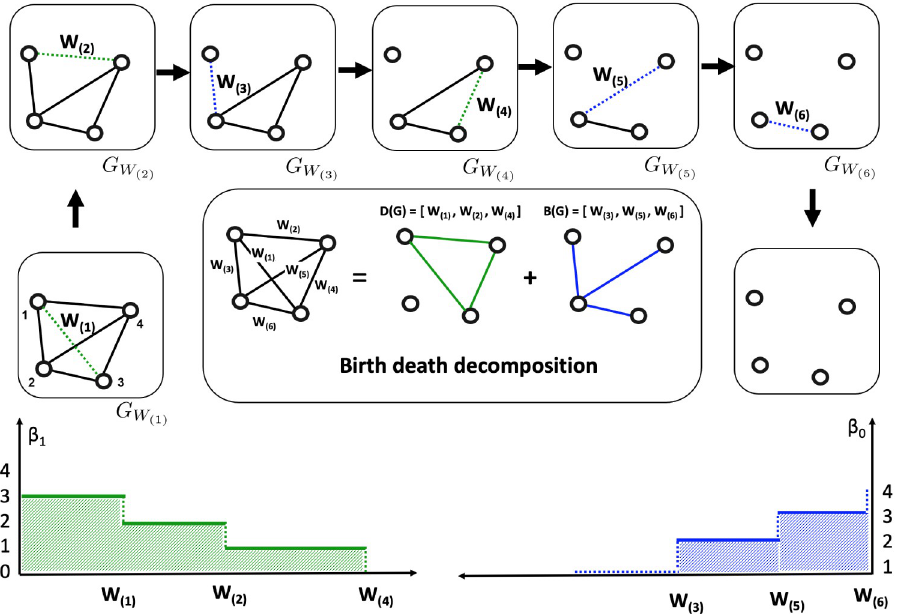
Fig 1. Schematic of graph filtration and persistent barcodes computation. We consider a random weighted graph with p = 4 nodes, where the number of edges is q = p ( p − 1)/2 = 6. The random edge weights are { W 1 , W 2 , ... , W 6 }. We order them using the order statistic as W (1) < W (2) < ��� < W (6) . We remove each edge of the random graph one at a time in the graph filtration and construct the random birth and death sets of the connected components and cycles, respectively. The Betti-0 (lower right) and Betti-1 (lower left) curves are drawn using the birth and death sets. The blue and green shaded areas represent the areas under Betti-0 and Betti-1 curves. Later, we will consider the area under Betti-0 curve to quantify the curve and construct a test statistic to discriminate between two groups of networks.